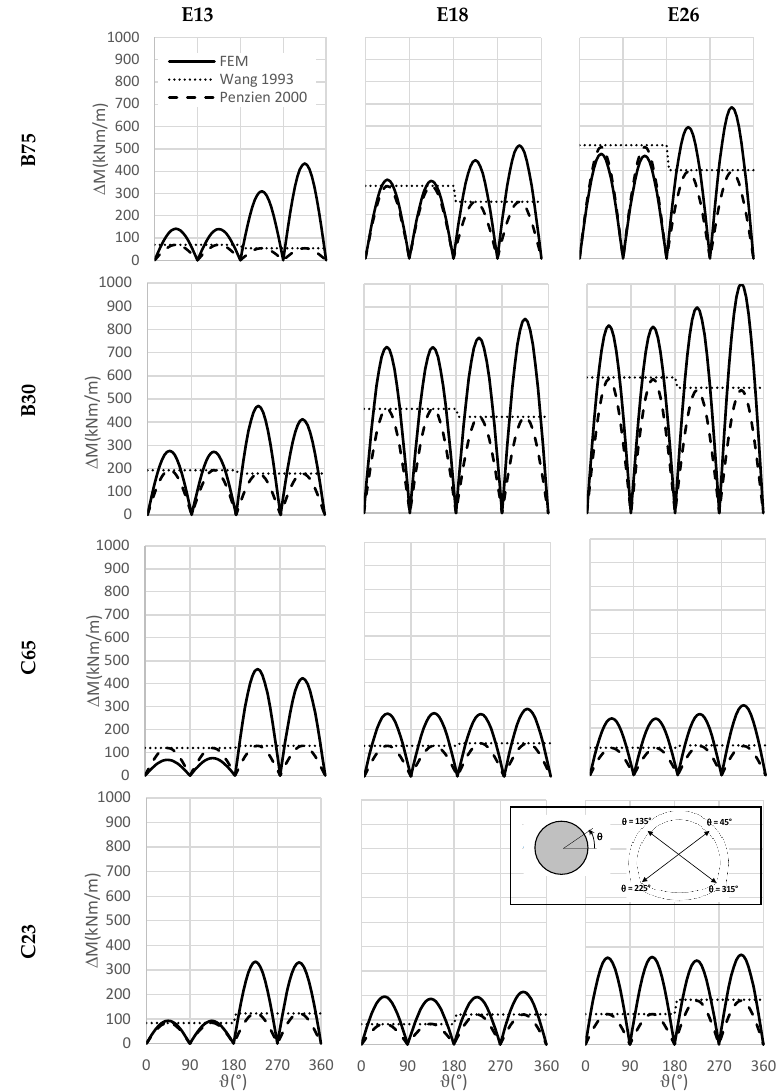
Figure 6. Comparison between numerical and analytical bending moments for some models (soil types B and C) studied in the equivalent visco-linear elastic analyses.